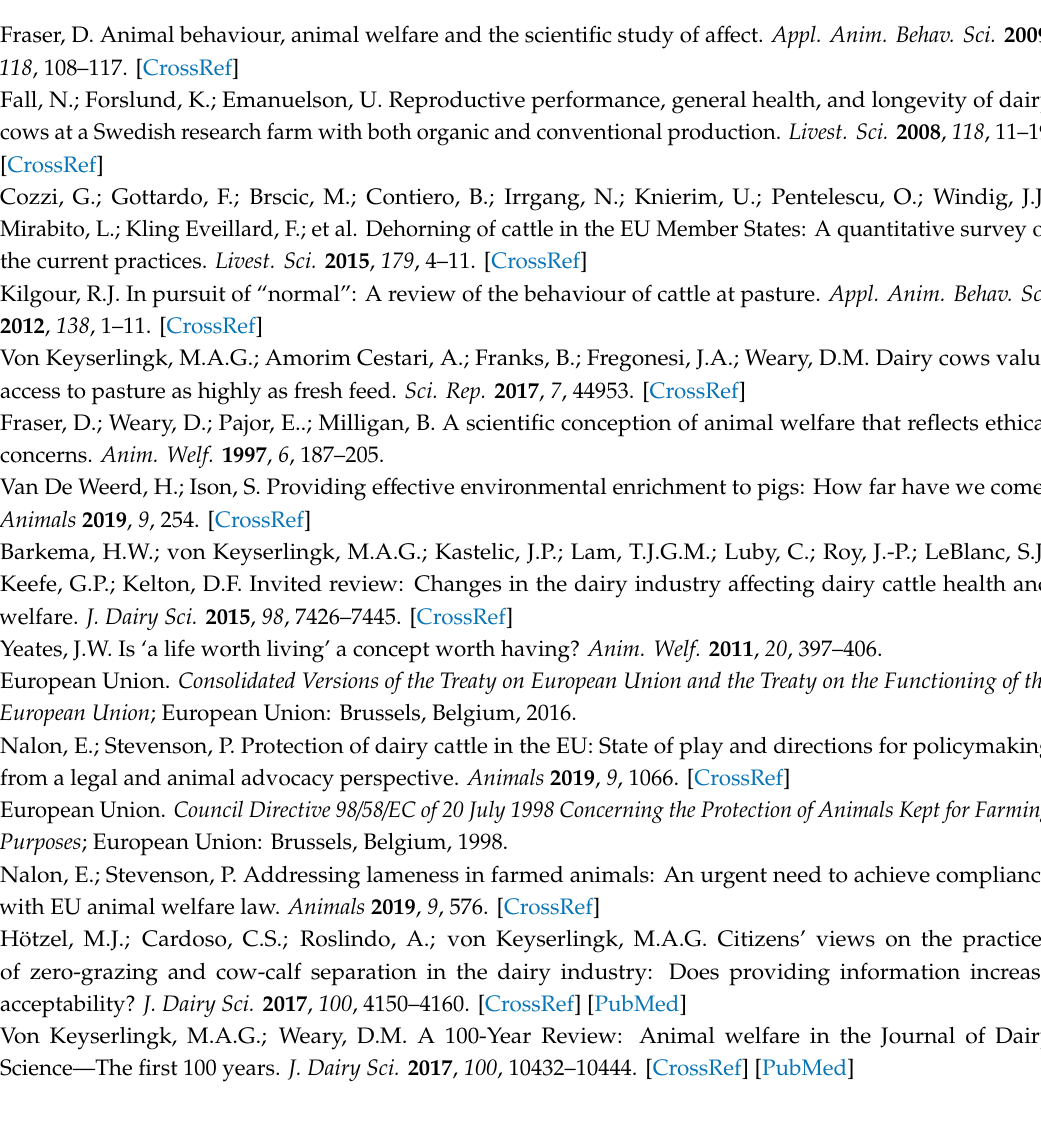
housing – flooring, Table S9: EU regulations related to housing – stocking density, Table S10: EU regulations related to outdoor access, Table S11: EU regulations related to outdoor – characteristics, Table S12: EU regulations related to open air area ( = excluding pasture) – density, Table S13: Main features of the EU regulations related to health, Table S14: EU regulations related to transportation – fitness for transport, Table S15: EU regulations related to transportation – means of transport, Table S16: EU regulations related to transportation – loading, unloading and handling, Table S17: EU regulations related to transportation – watering / feeding intervals, journey times, resting periods, Table S18: Main features of the EU regulations related to slaughtering, Table S19: EU regulations related to breeding – reproduction, Table S20: EU regulations related to sta ffi ng, Table S21: EU regulations related to inspection, Table S22: EU regulations related to